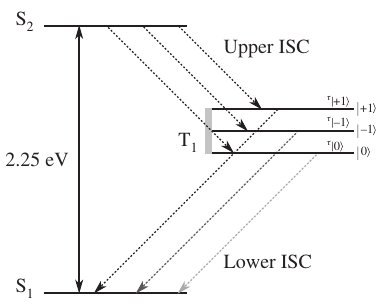
Figure 1: The known electronic structure of the ST1 center. S and S are the ground and excited singlets, respectively. T 1 2 metastable triplet state. The dotted lines indicate the ISCs, and the solid arrow represents the optical ZPL. The lower ISCs are labelled by their depopulation rates, τ